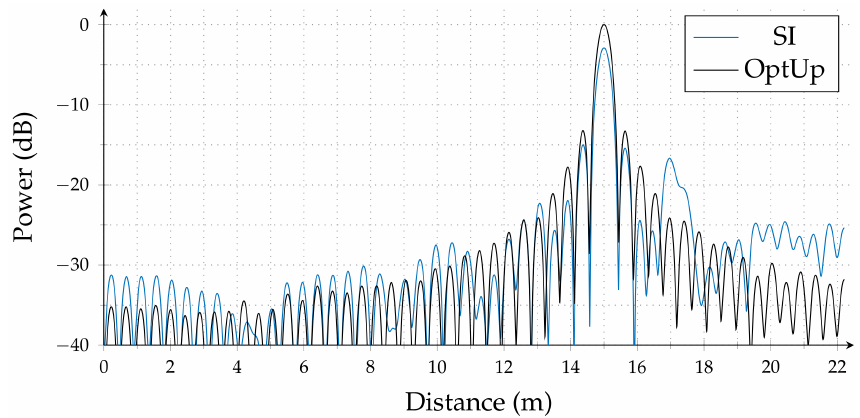
Figure 4. Simulation-based comparison of standard interpolation (SI) vs. optimal upsampling approach (OptUp).